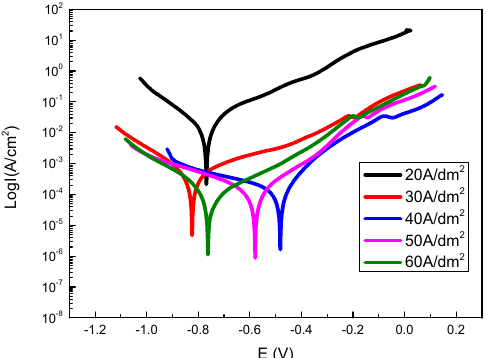
Figure 10. Polarization curves of corrosion resistance of composite coatings prepared at different current densities. Table 5 . Parameter values of polarization curve.